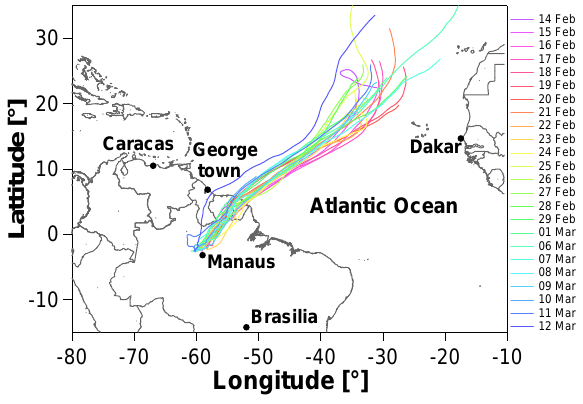
Fig. 1. Location of the AMAZE-08 measurement site in cen- Fig. 1: Location of the AMAZE-08 measurement site in central Amazonia (2.594541 S, 60.209289 W), 60 tral Amazonia (2.594541S, 60.209289W), 60km NNW of Man- km NNW of Manaus, Brazil, with 9 day back trajectories (HYSPLIT, NOAA-ARL, GDAS1 model, start aus, Brazil, with 9 day back trajectories (HYSPLIT, NOAA-ARL, height 50 m, start time 23:00 UTC) illustrating the large scale airflow during the CCN measurement period GDAS1 model, start height 50m, start time 23:00UTC) illustrat- (14 Feb – 12 Mar 2008). ing the large scale airflow during the CCN measurement period (14 February-12 March